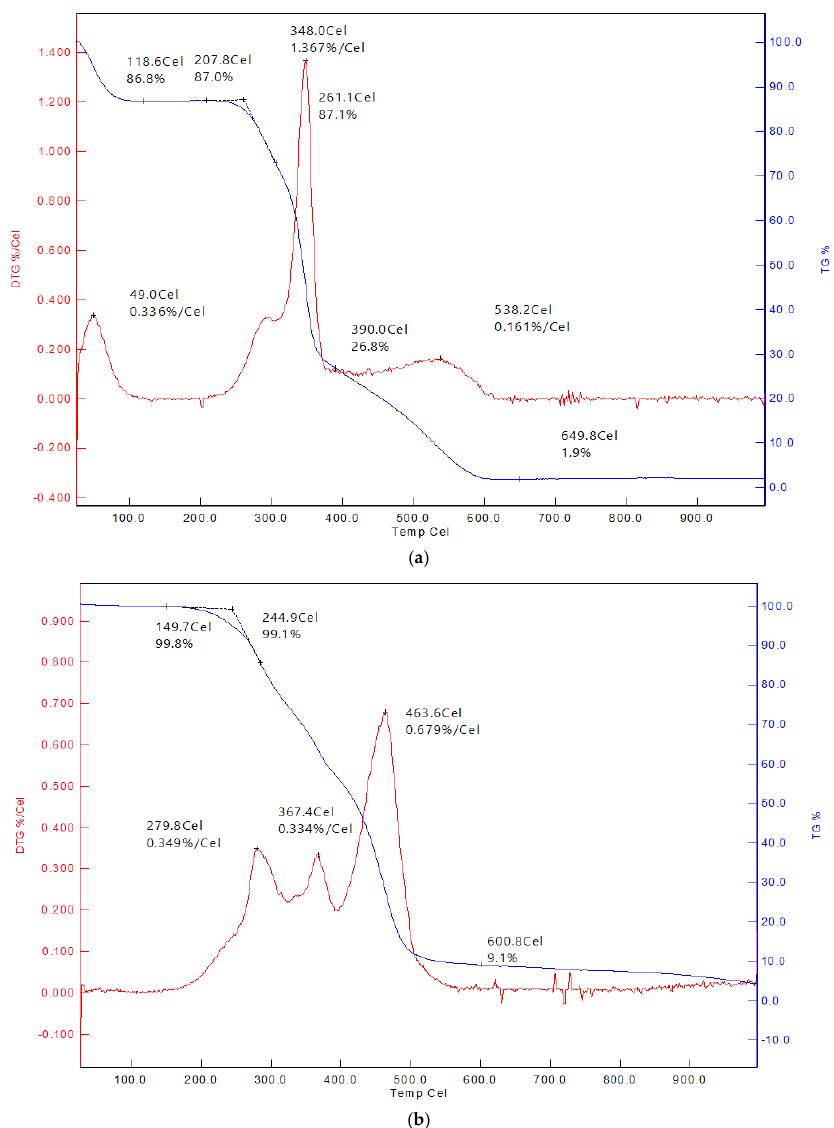
Figure 4. TGA/DTG curves: ( a ) wood, ( b ) adhesive. Note: The blue color represents the results of the TGA and the red color the results of the DTG of the materials evaluated.